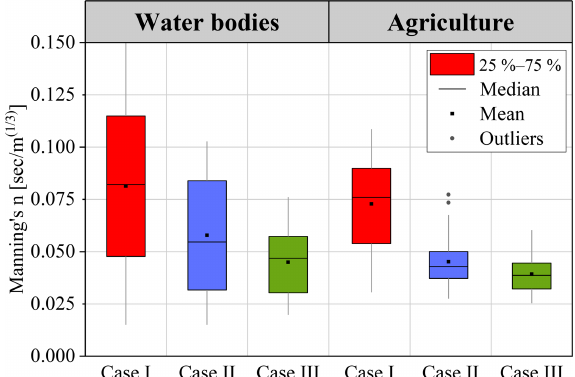
Figure 8. Box plot of Manning’s n of water bodies and agriculture for three